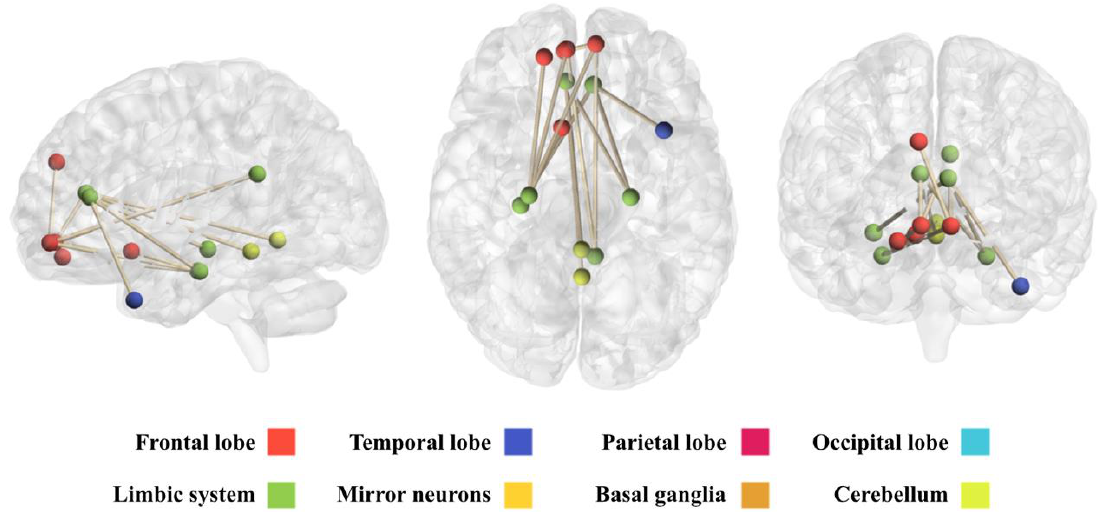
Figure 6. Representation of the network obtained under the underconnectivity hypothesis. From left to right: sagittal, axial and coronal views of the brain. Representation obtained with the BrainNet Viewer Toolbox [21].